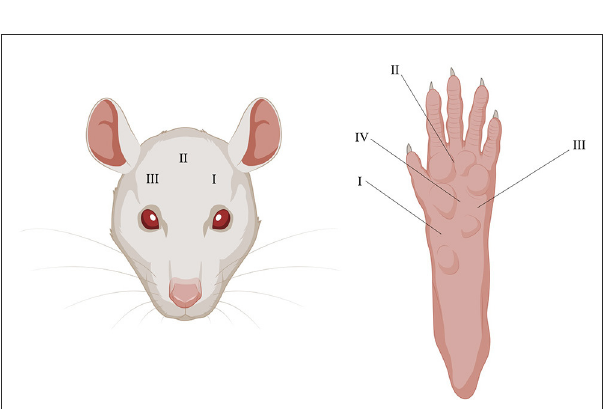
FIGURE1 Experimental design. Illustrative depiction of the experimental timeline.